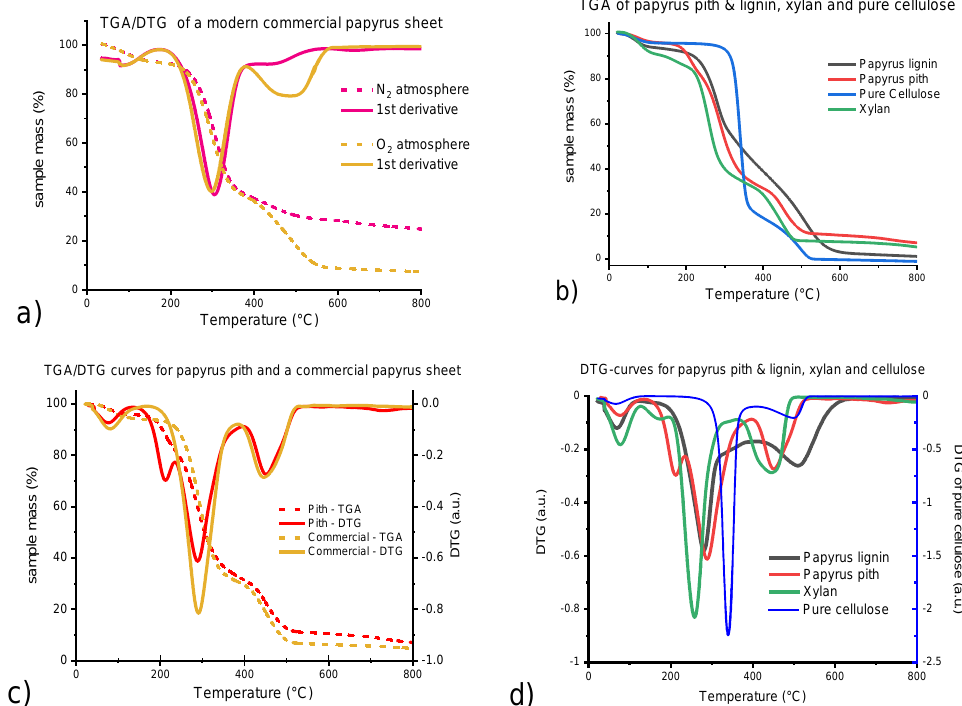
Figure 2. ( a ) Thermogravimetry (TGA) and derivative thermogravimetry (DTG) curves for a commercial papyrus sheet sample in nitrogen and oxygen atmosphere; ( b ) TGA curves (oxygen atmosphere) for papyrus lignin, papyrus pith, pure cellulose (Whatman filter paper No. 1), and a xylan sample. ( c ) TGA/DTG curves (oxygen atmosphere) for native papyrus pith and a commercial papyrus sheet (obtained one year later from the same supplier as the sample in ( a )). ( d ) DTG curves (oxygen atmosphere) for papyrus lignin, papyrus pith, xylan, and pure cellulose (blue). DTG for pure cellulose is depicted on the right Y -axis (blue, different scale).